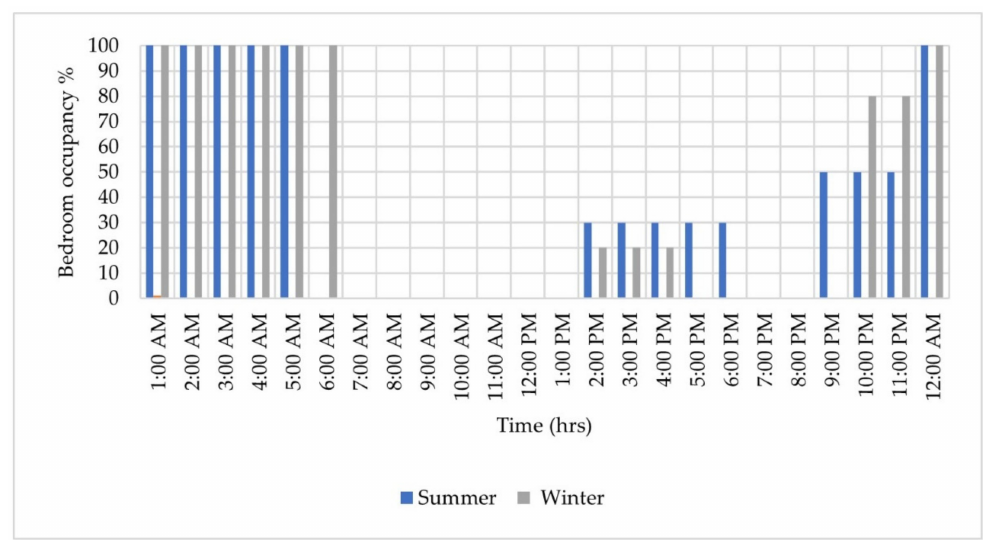
Figure A1. Bedroom occupancy schedule.